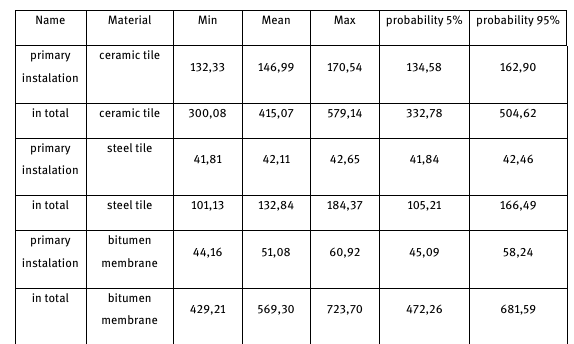
Table 4: The input data for calculations Table 5: The output data of calculation